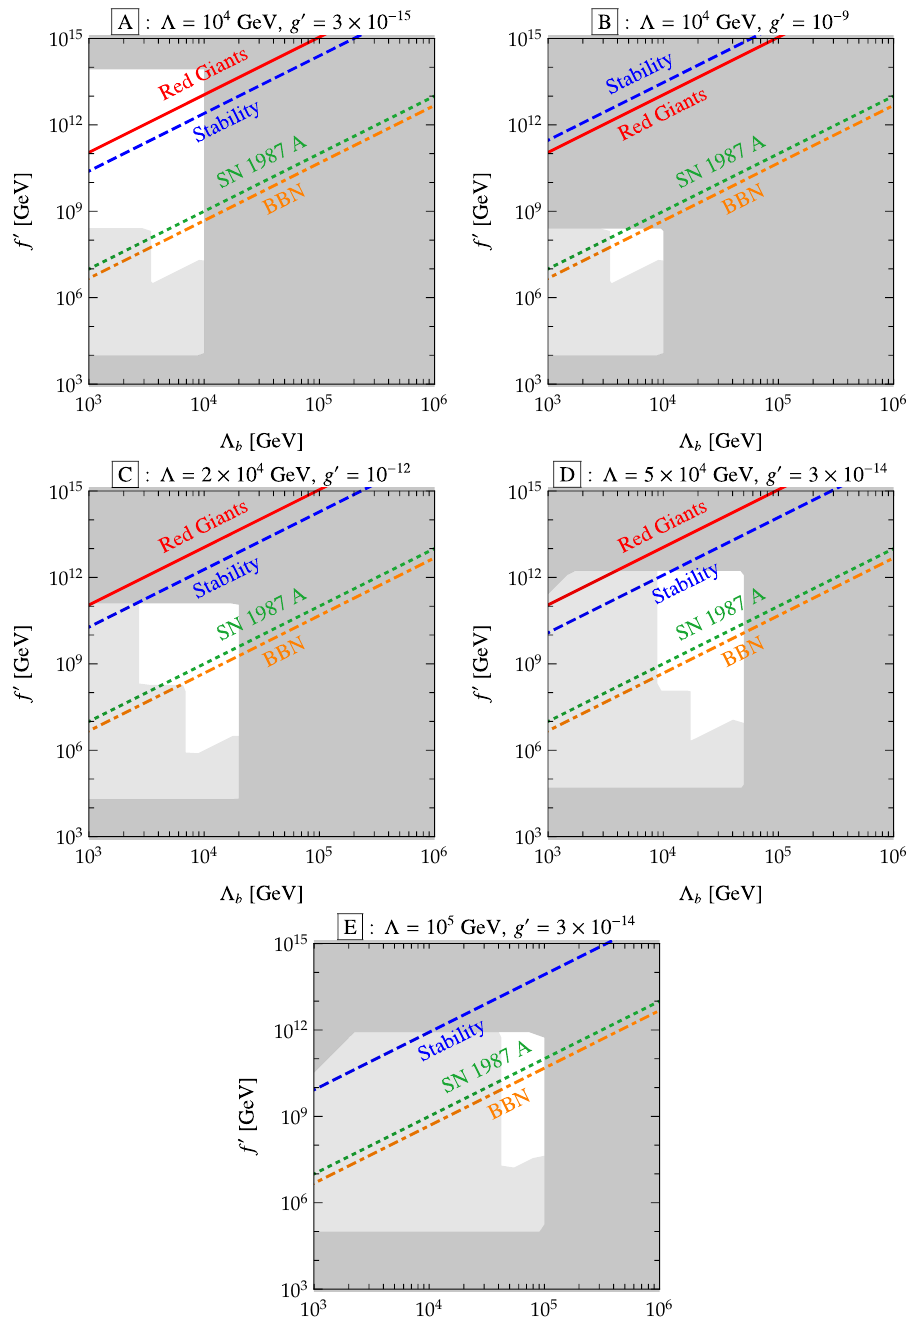
Figure 15 . Combination of all the cosmological and astrophysical constraints for each of the (cid:12)ve benchmark points in the plane [(cid:3) b ; f 0 ] de(cid:12)ned in eq. (5.28) and shown in red in (cid:12)gure 8. The white area denotes the allowed region shown in (cid:12)gure 9. In the gray region the conditions necessary for particle production are not satis(cid:12)ed (the light gray area refers to the exclusion bounds which rely on assumptions about the thermalisation process). The astrophysics bounds (red giants and SN 1987 A) (see section 7.4), the relaxion abundance (see section 7.2) and distortions on the abundance of light elements (see section 7.3) set an upper bound on the scale f 0 for a given (cid:3) b .